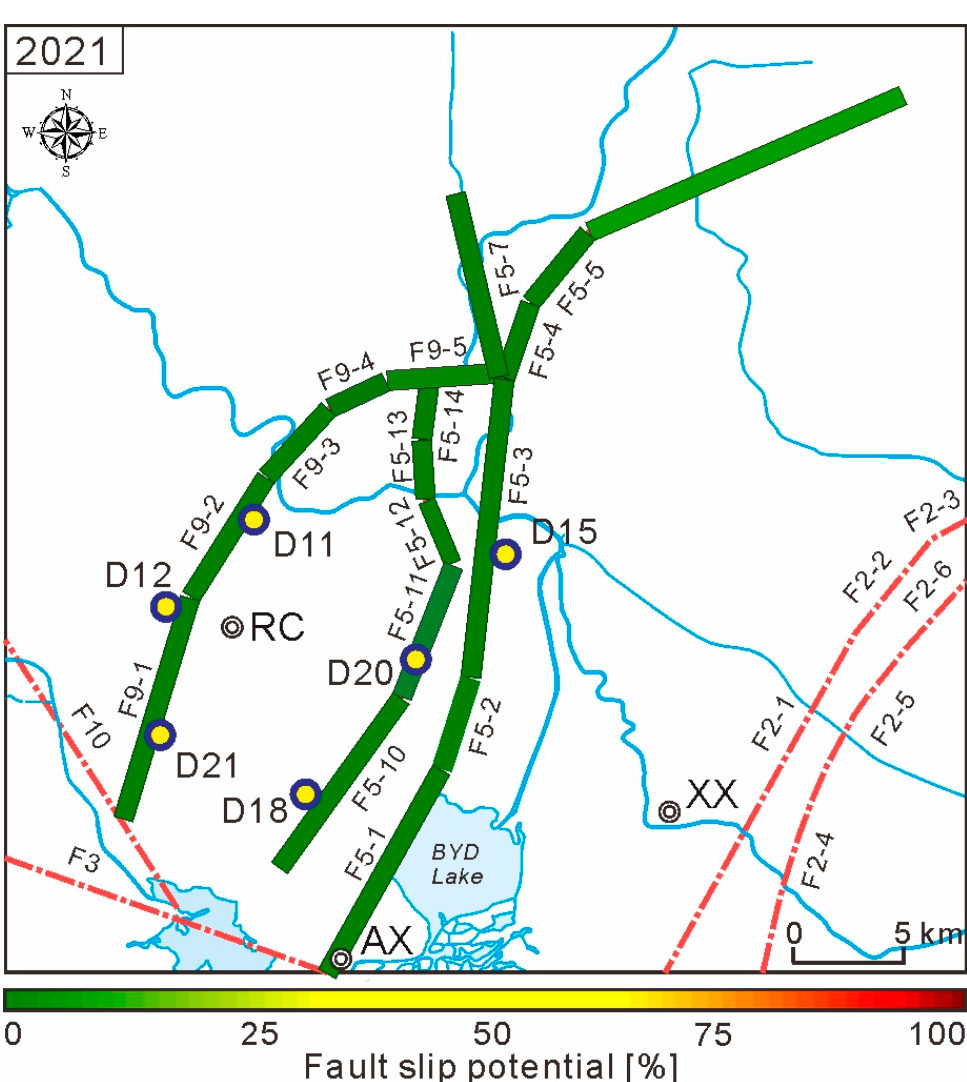
Figure 6. The initial fault slip potential of the main active faults in the Rongcheng deep geothermal reservoir area at a reference depth of 2600 m.